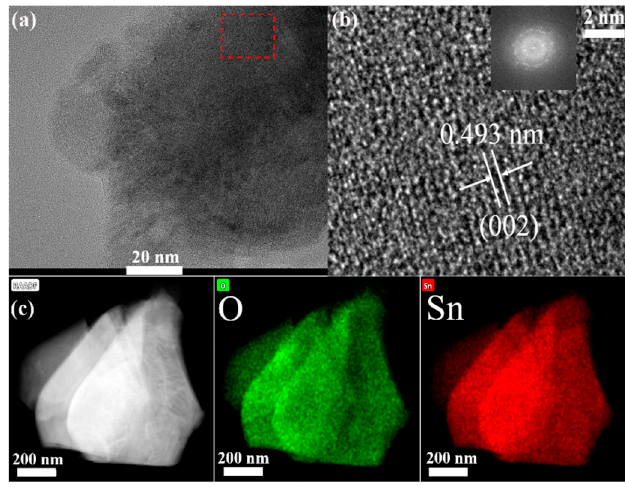
Figure 4. TEM images of sample S1 ( a ) TEM, ( b ) HRTEM image recorded on the area marked by the red rectangle in ( a ) (insert: simulated selected area electron diffraction (SAED) image) and ( c ) energy dispersive spectrometry (EDS) elemental mappings.